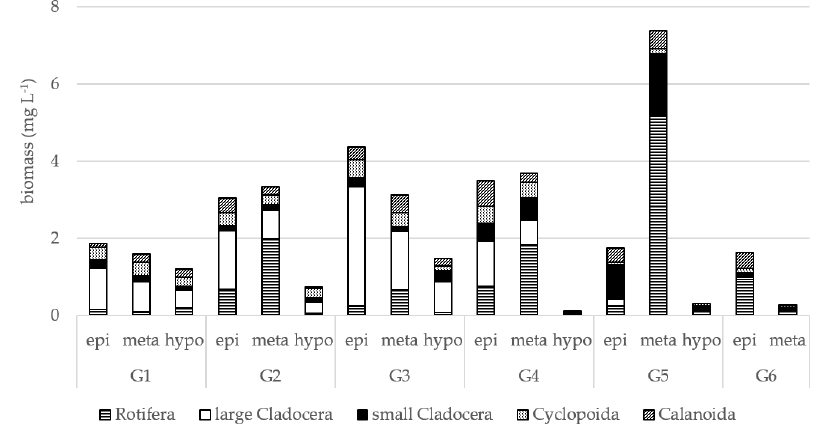
species with the highest biomass in dystrophic lakes were Asplanchna priodonta , Ceriodaphnia quadrangular, and Eudiaptomus gracilis .